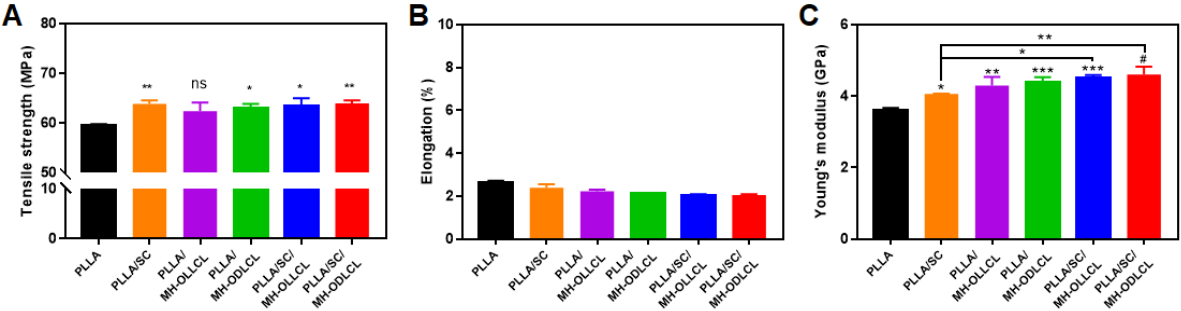
Figure 5. Mechanical properties of the PLLA, PLLA/SC, PLLA/MH–OLLCL, PLLA/MH–ODLCL, PLLA/SC/MH–OLLCL, and PLLA/SC/MH–ODLCL composites: ( A ) tensile strength, ( B ) elongation, and ( C ) Young’s modulus ( * p < 0.05, ** p < 0.01, *** p < 0.001, # p < 0.0001).